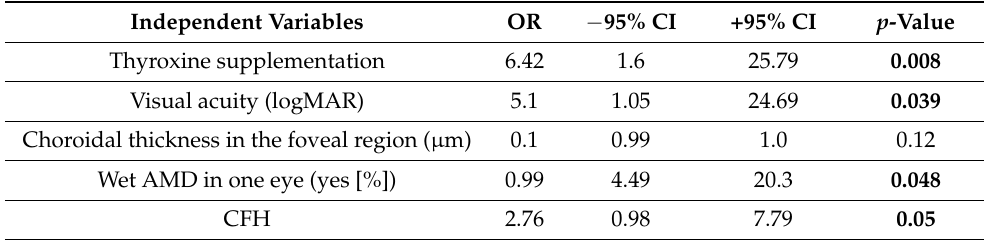
Table 3. Multivariate logistic regression analysis of patients considering the presence of AMD progression as a dependent variable, adjusted for age and